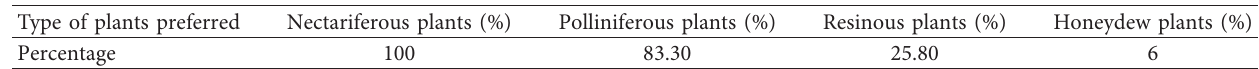
Table 4: Type of plants preferred by beekeepers for the installation of hives. Type of plants preferred Nectariferous plants